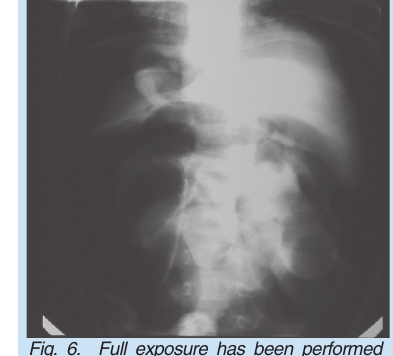
Fig. 6. Full exposure has been performed and the image contrast reversed to demon- strate free air in the recognisable ‘black’ form after perforation.